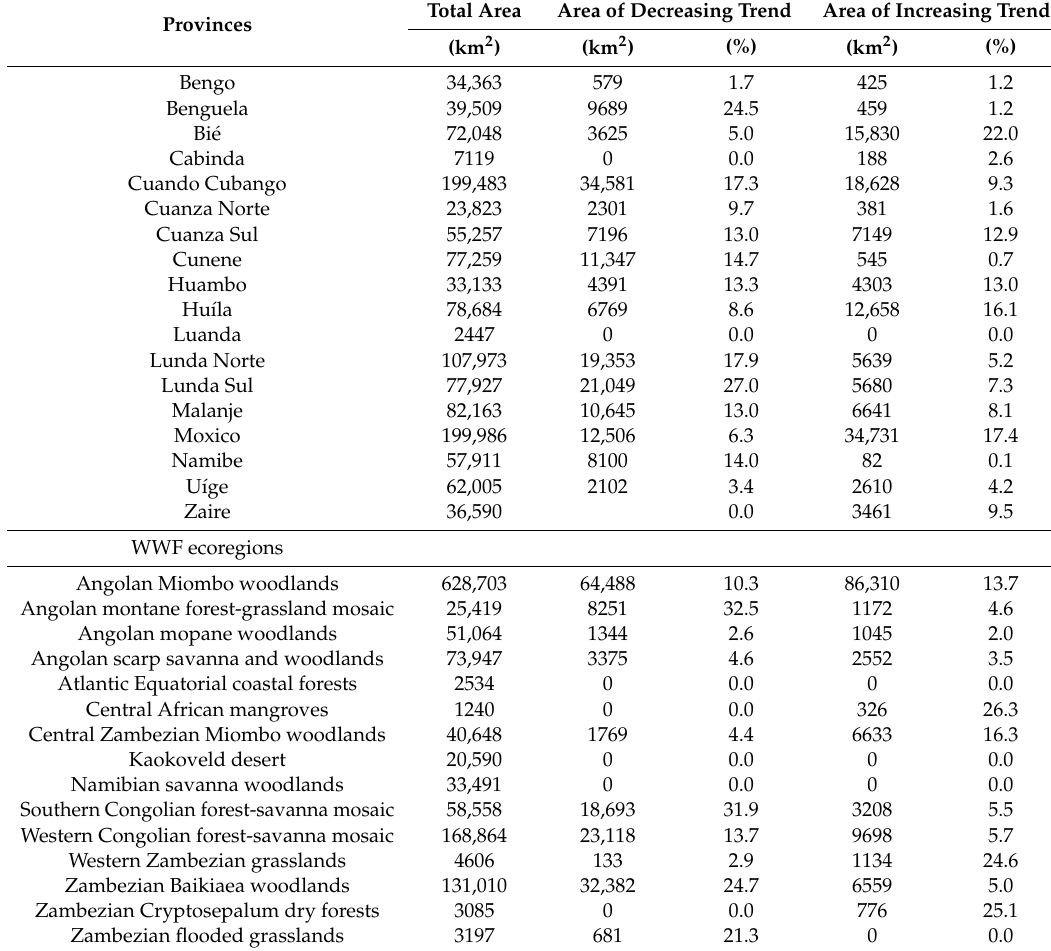
Figure 5. Areas of significant increasing and decreasing trends in Angolan provinces. Table 1. Area and proportion of increasing and decreasing significant trends of annual burnt area in Angolan provinces, WWF ecoregions, and protected areas, from 2001 to 2019.